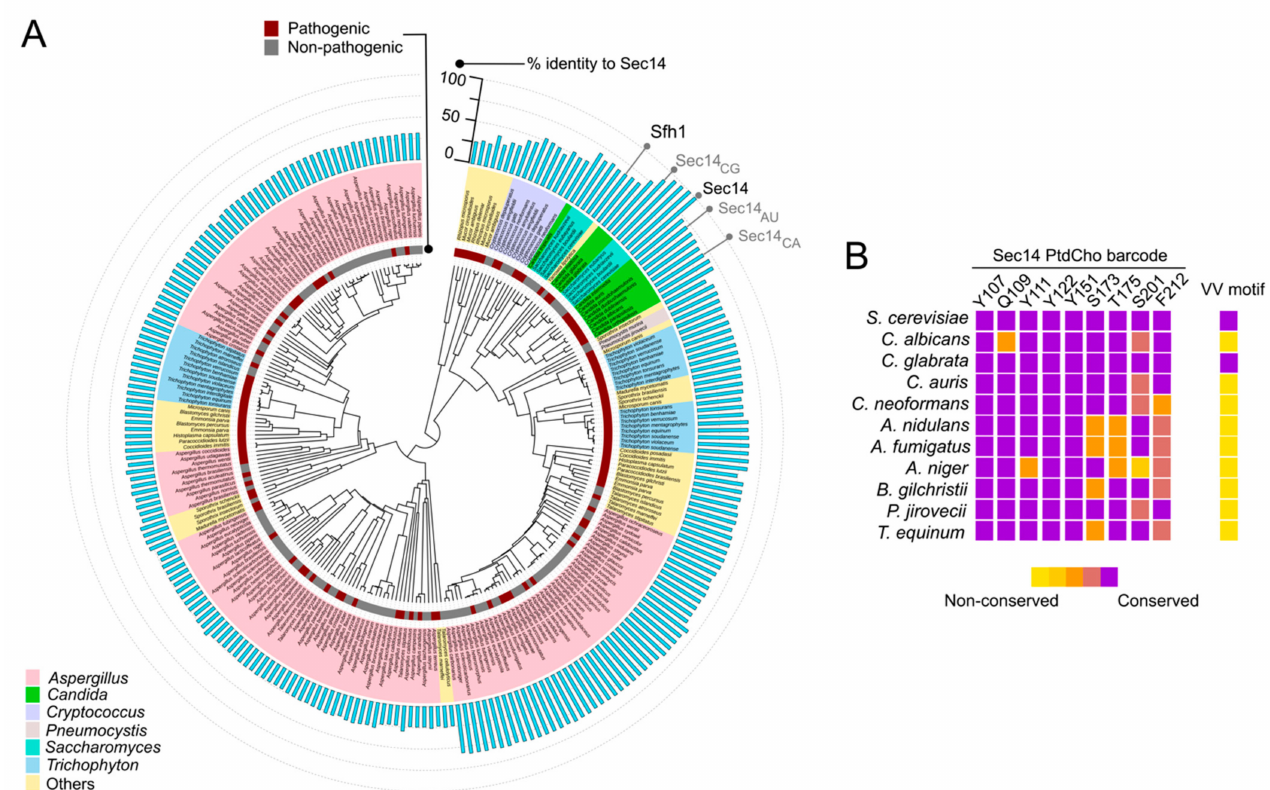
Figure 7. Phylogenetic analysis of fungal Sec14s. ( A ) Phylogenetic analysis of fungal Sec14s. ( A ) Sec14 domain sequences from Saccharomyces and major fungal pathogens listed on CDC website (https://www.cdc.gov/fungal/diseases/index.html) were compiled from the Ensembl fungal database (https://fungi.ensembl.org/index.html). The alignment file was processed in JalView to eliminate redundancy and includes only entries with 200 to 800 amino acids. Percent identity to S. cerevisiae Sec14 was calculated by pair-wise alignment of each entry using BLAST (https://blast.ncbi.nlm.nih.gov/Blast.cgi). A multiple sequence alignment was performed with the processed sequences using NGPhylogeny.fr portal and the MAFFT 7.4 algorithm [152]. The phylogenetic tree was visualized using the iTol website (https://itol.embl.de) [153] annotated with a bar graph showing percent identity of each entry to S. cerevisiae Sec14. Maroon strip indicates virulent fungi, and the grey strip represents non-pathogenic fungi. Fungi are color coded according to genus as indicated. Percent identity of each Sec14-like domain to S. cerevisiae Sec14 is indicated by bar graph (blue). The bars corresponding to Sec14 homologs from C. glabrata (Sec14 CG ), C . auris (Sec14 AU ), and C. albicans (Sec14 CA ) are labeled in grey. S. cerevisiae Sec14 and its close paralog Sfh1 are labeled in black. ( B ) Heat-map depicting the conservation of key PtdCho binding residues and VV-motif in Sec14 orthologs from the following ten virulent fungal species are shown: C. albicans , C. glabrata , C. auris , C. neoformans , A. nidulans , A. fumigatus , A. niger , B. glichristii , P. jirovecii, and T. equinum . Accessed on 16 June